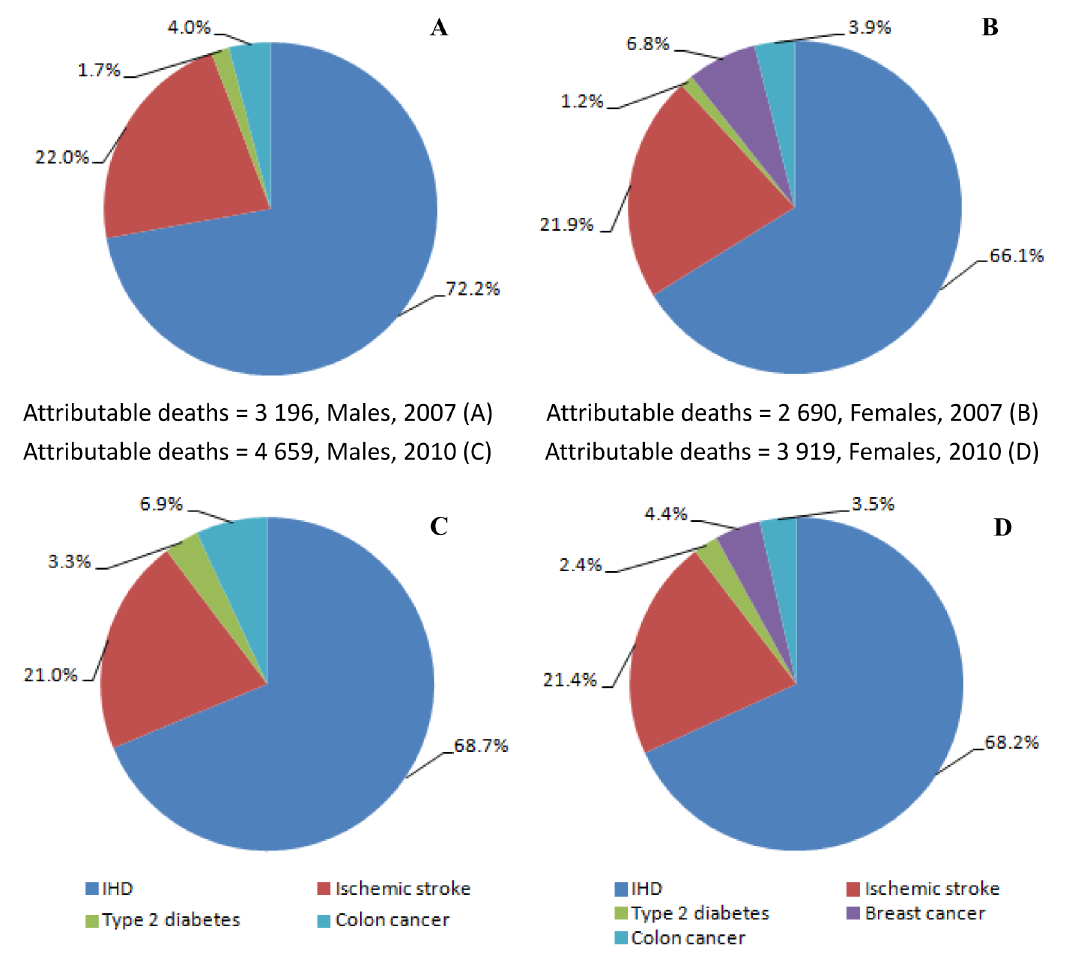
Figure 2. Deaths attributable to insufficient physical activity by sex and conditions, Jiangxi province of China, 2007 and 2010.